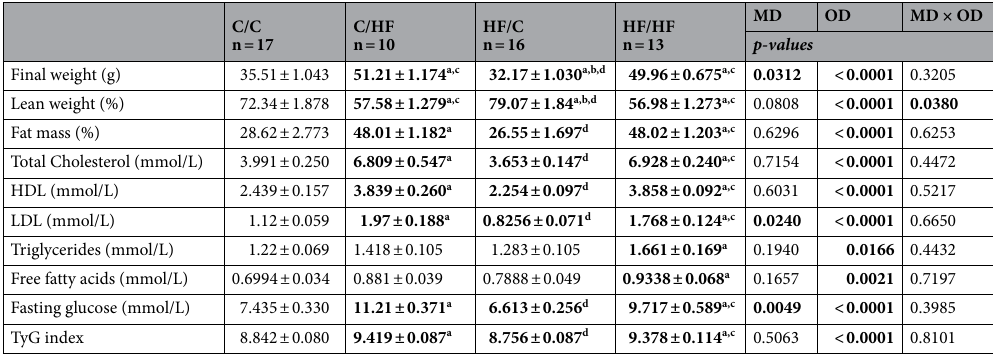
Table 1. The effects of maternal and male offspring high-fat diet in metabolic parameters of offspring. Data presented as mean ± SEM. N = 10–17 animals from 7–9 litters per group. Groups were analysed by Two- way ANOVA and Tukey’s post-test for multiple comparisons. Bold values depict statistical differences. The interaction between the two variables denotes that the effect of one variable is dependent on the other. C/C dam and offspring fed standard laboratory diet; C/HF dam fed standard laboratory diet and offspring fed high-fat diet; HF/C dam fed high-fat diet and offspring fed standard laboratory diet; HF/HF dam and offspring fed high fat diet, MD maternal diet, OD offspring diet, MDxOD interaction between MD and OD, HDL high-density lipoprotein, LDL low-density lipoprotein. a p < 0.05 vs C/C. b p < 0.05 vs C/HF. c p < 0.05 vs HF/C. d p < 0.05 vs